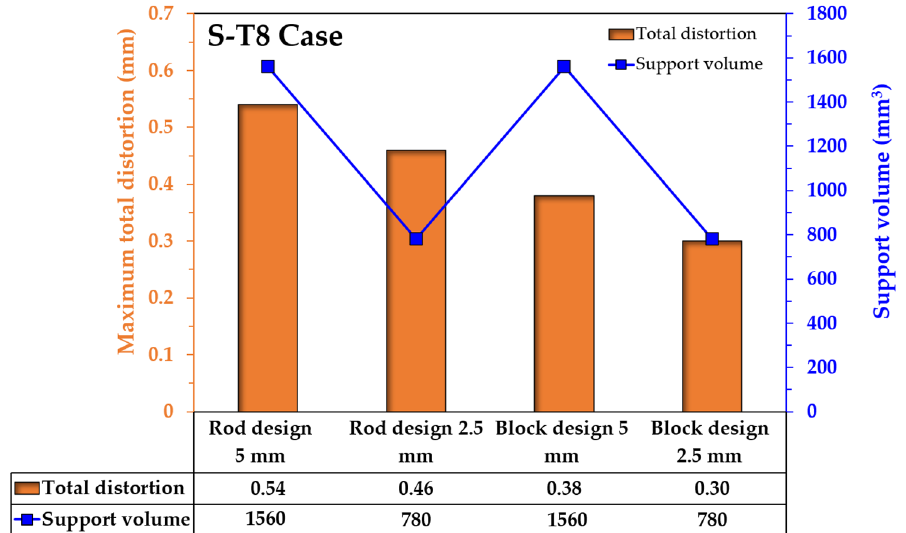
Figure 15. The maximum total distortion of the S-T8 tibial component fabricated with different sup- port